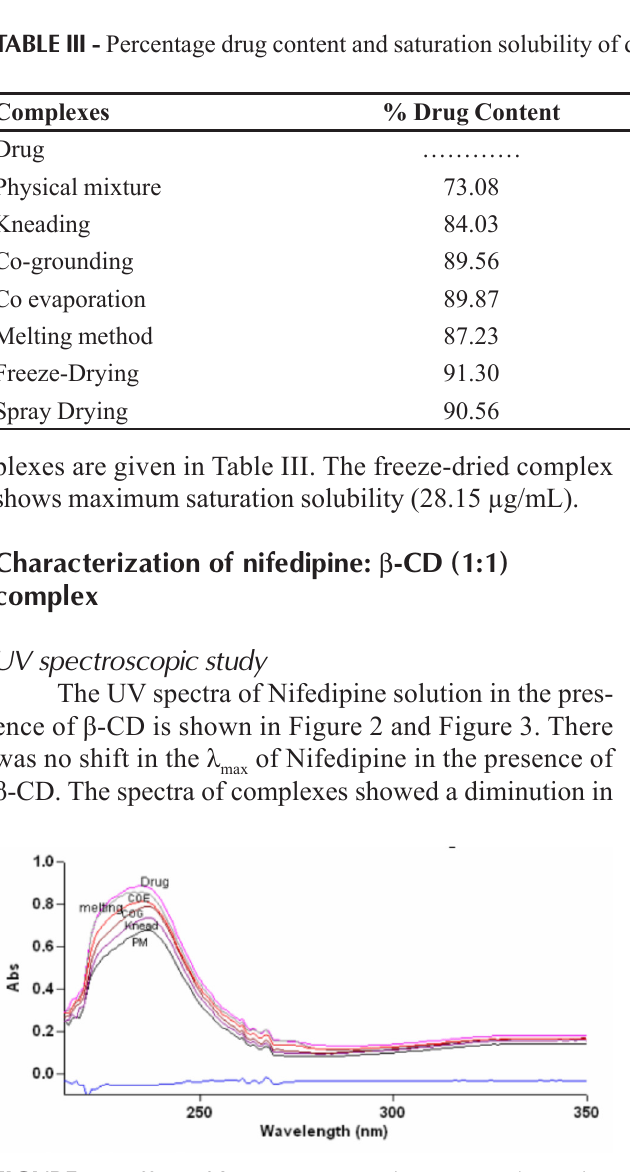
FIGURE 2 - Effect of β -CD concentration on UV absorption of nifedipine.